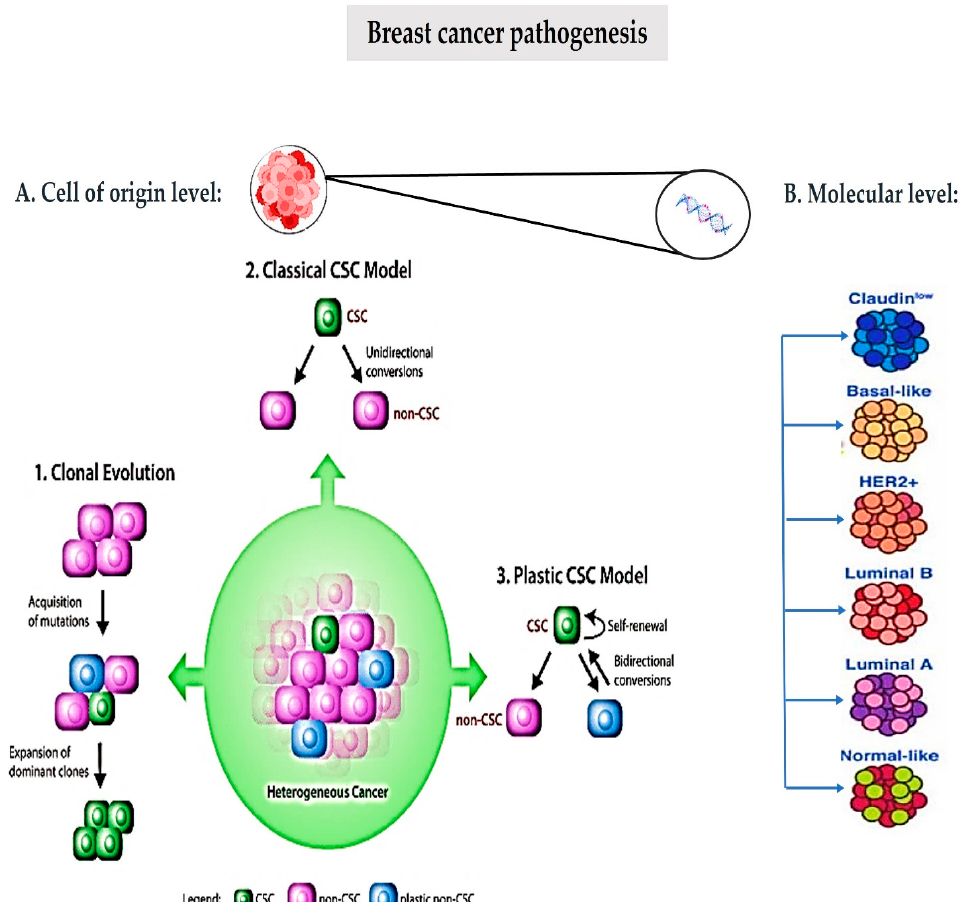
Figure 2. Mechanisms underlying breast cancer pathogenesis. ( A ) Cell-of-origin schematic descrip- tion of the clonal evolution theory and the classical CSC (cancer stem cell) and plastic stem cell models; ( B ) Molecular studies of numerous genetic and epigenetic alterations has led to the classification into six subtypes (normal-like, luminal A, luminal B, HER2-enriched, claudin-low, and basal-like).